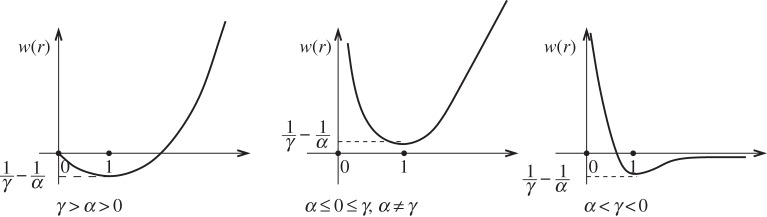
Three different behaviours of w(r)=rγ/γ−rα/α, γ>α.